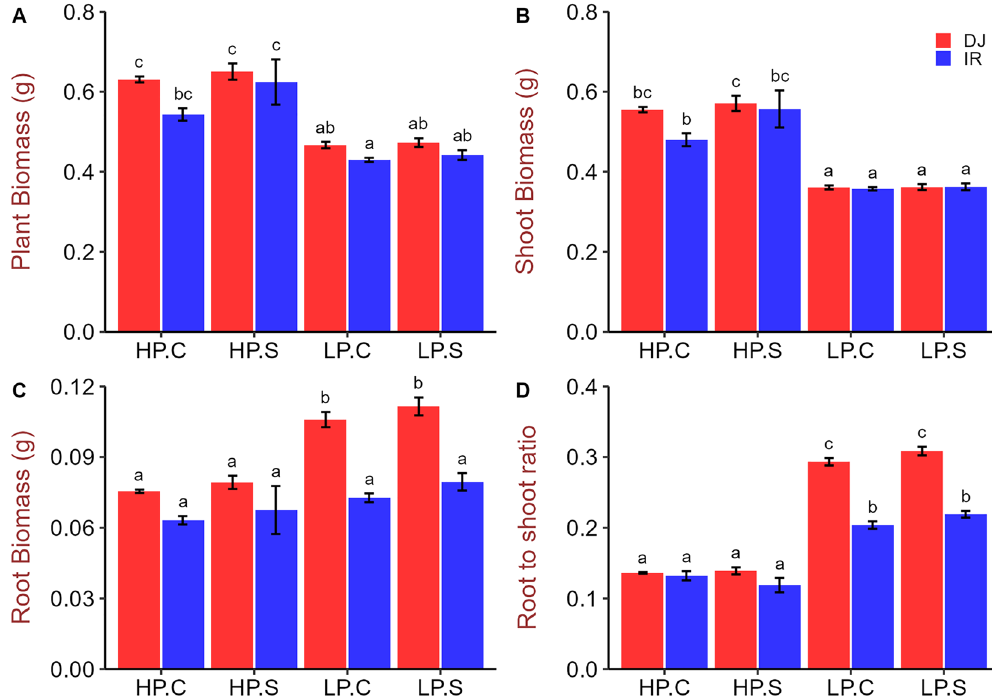
Figure 1. Whole plant, shoot and root biomass production and root-to-shoot biomass ratio of DJ123 and IR64 grown under varying phosphorus supply. Data are the mean ± SE of three to four independent replicates. ‘HP’ and ‘LP’ stand for high- and low-phosphorus supply, respectively. Plants were grown on HP and LP treatments for 40 days after germination. Then, both groups were splitted into two sub-groups. P supply was continued as usual for one sub-group of each treatment (labelled as ‘C’) and stopped for the other group (labelled as ‘S’). After approximately 24 and 48 h, LP and HP sub-groups were harvested, respectively. Significant differences